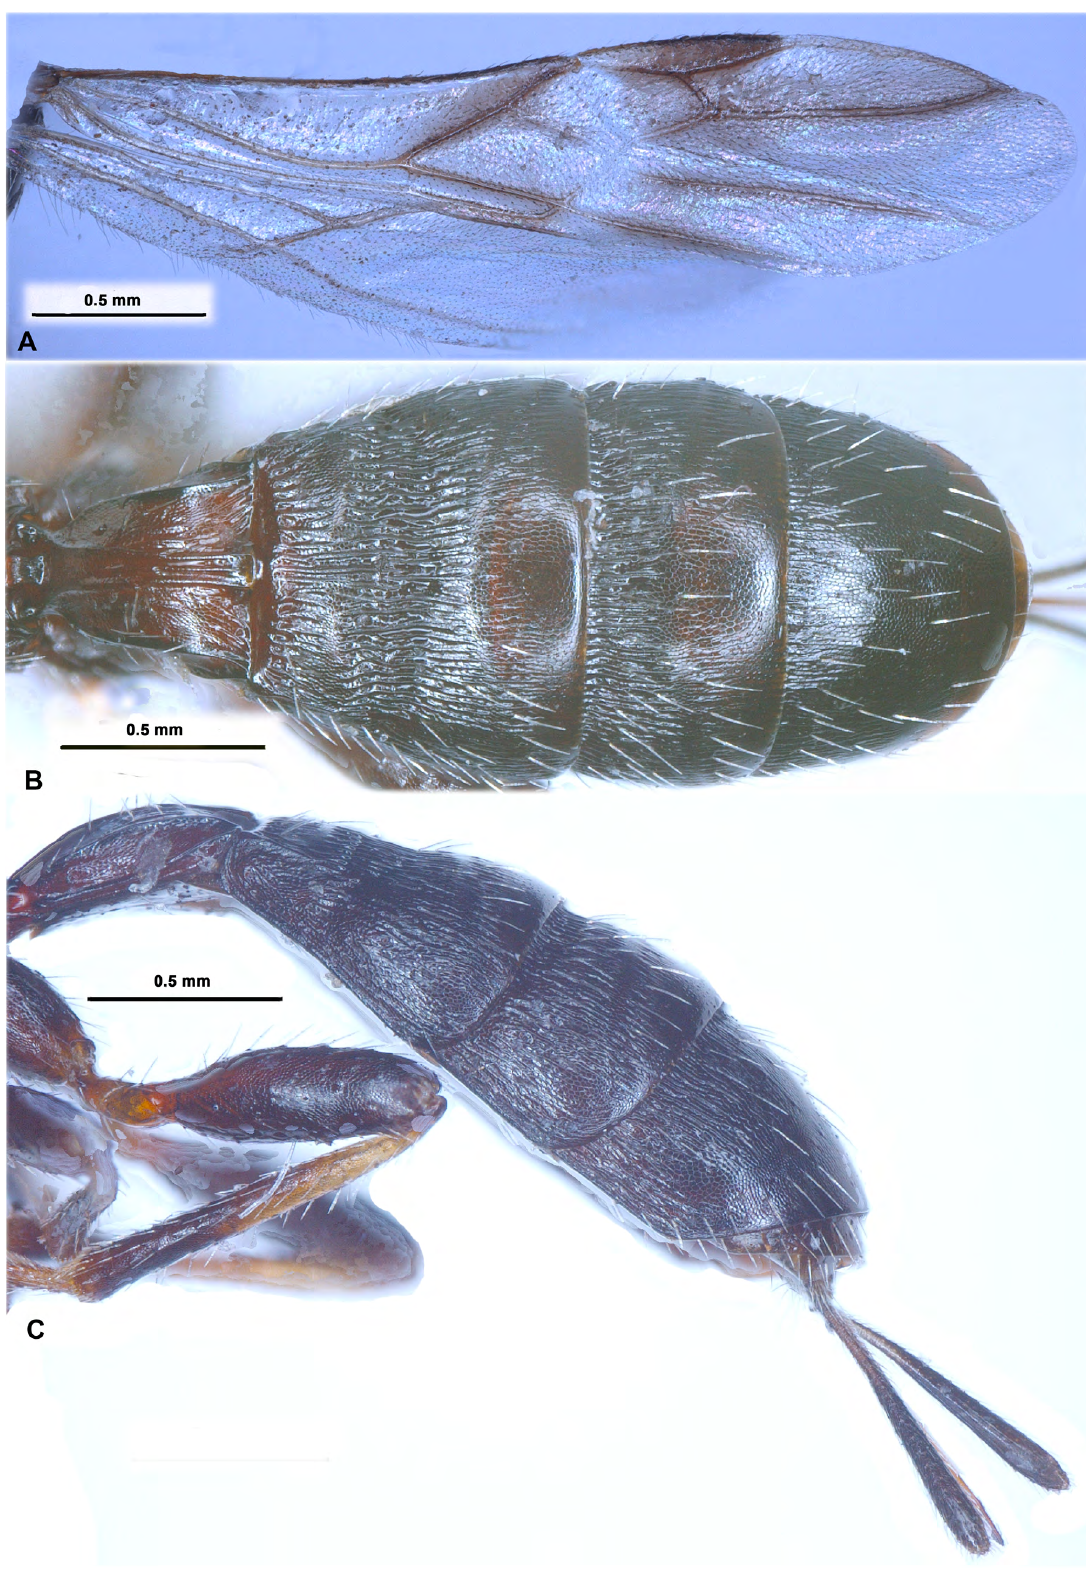
Fig. 39. Pseudorhaconotus enervatus van Achterberg & Shaw, 2010, ♀, holotype, NMS. A . Wings. B . Metasoma, dorsal view. C . Metasoma and hind leg, lateral